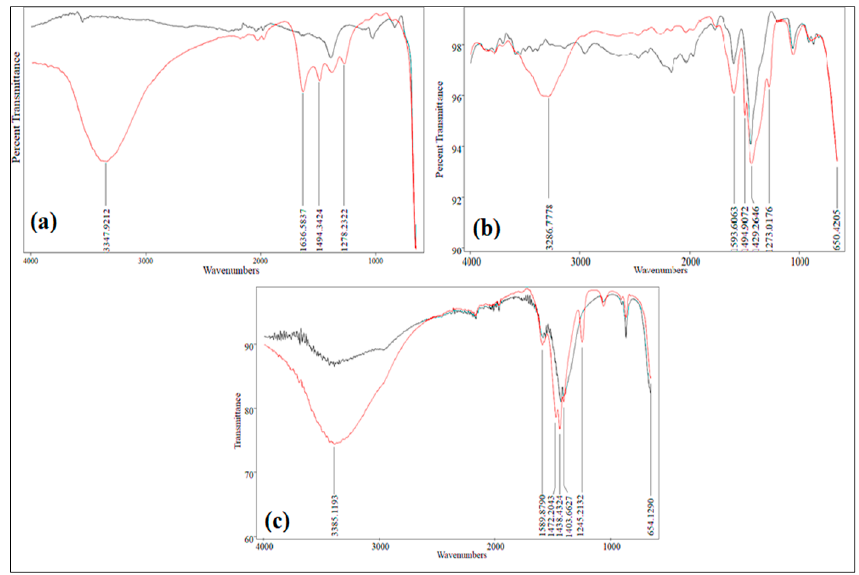
Figure 5. FTIR spectra of ( a ) NC1and PDA-coated NC1, ( b ) NC2 and PDA-coated NC2, ( c ) NC3 and PDA-coated NC3.